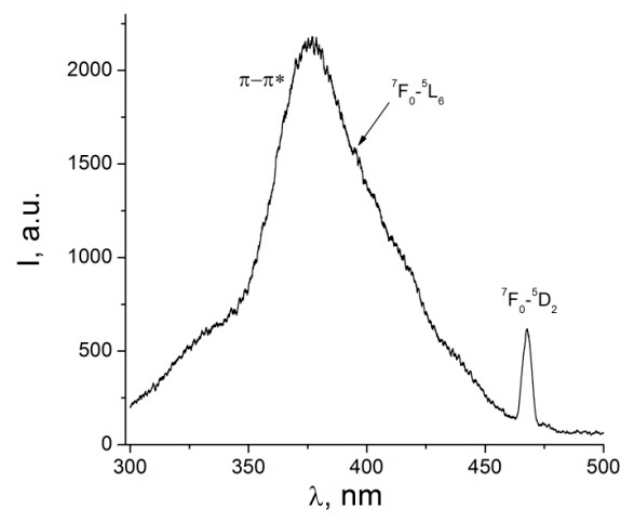
Figure 2. Low-resolution excitation spectrum of the complex ( 1 ) at 300 K for the 5 D 0 → 7 F 2 transition.